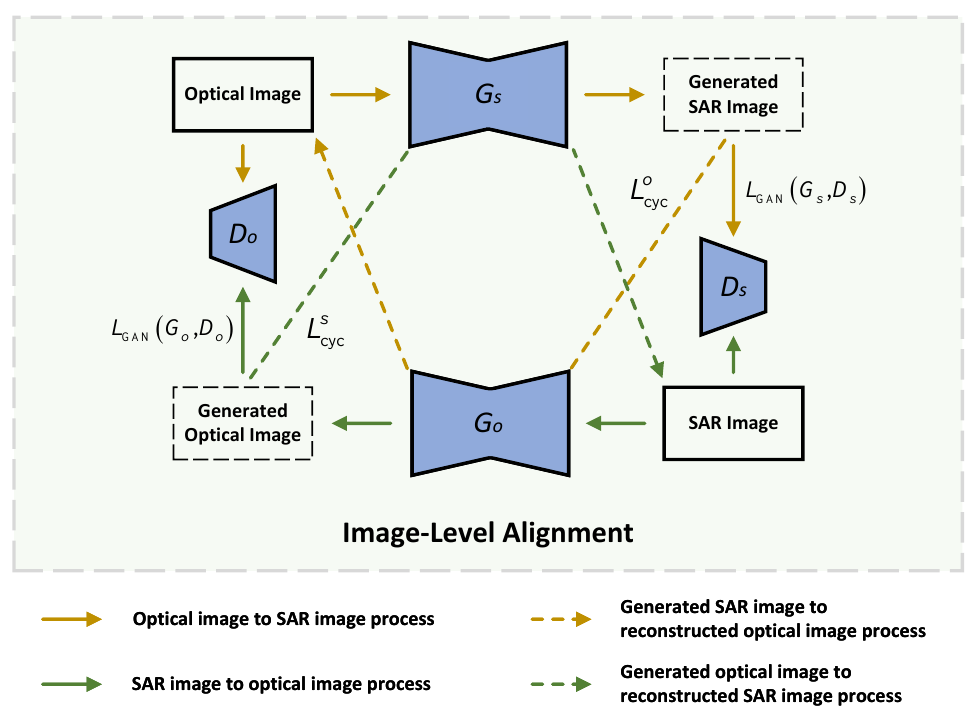
Figure 4. Image-level alignment structure. Image-level alignment aims to transfer the optical image into the SAR